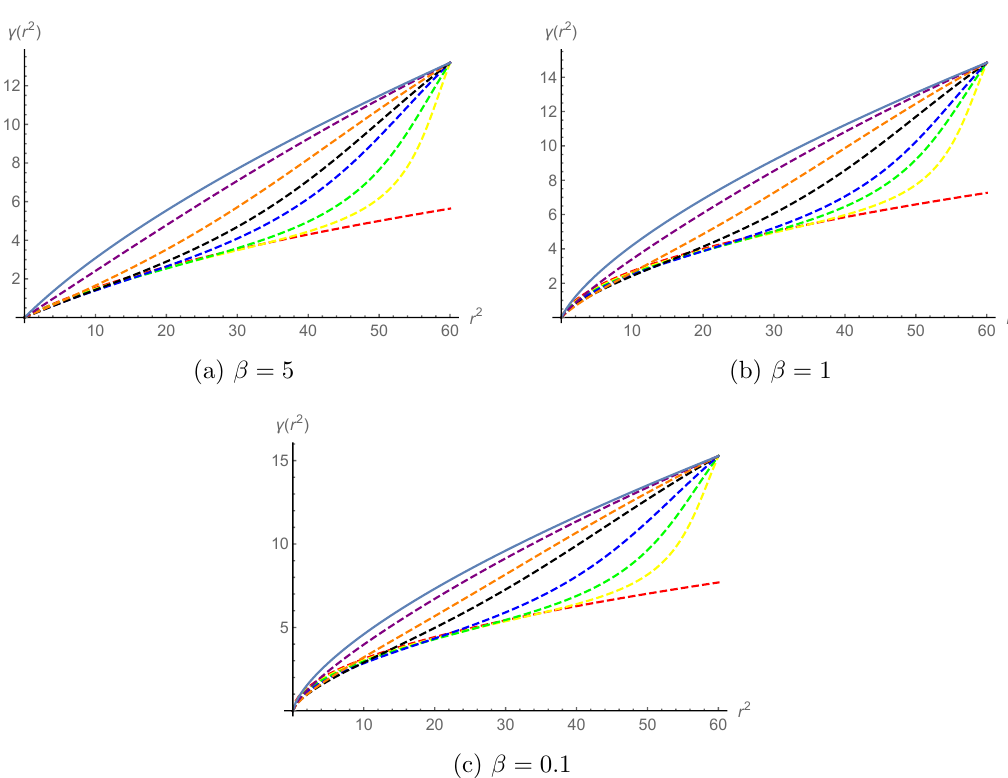
Figure 3. Larger r 2 test of convergence of the IR (cid:13)ow of (cid:13) ( r 2 ) from the starting UV point p (cid:13) = 2 r 2 = (cid:12) 2 + 4 r 2 (red dashed line) to the analytic IR solution (solid blue line). From the bottom to the top dashed lines (yellow to purple), they represent the intermediate K(cid:127)ahler potentials from the early RG time to the late RG time. Also, in this case the boundary condition for iteration (cid:13)ows is set to match the analytic solution at r 2 =